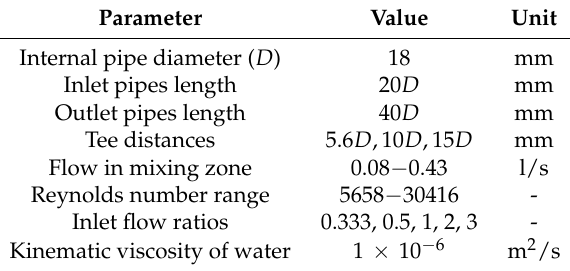
Table 1. Experimental